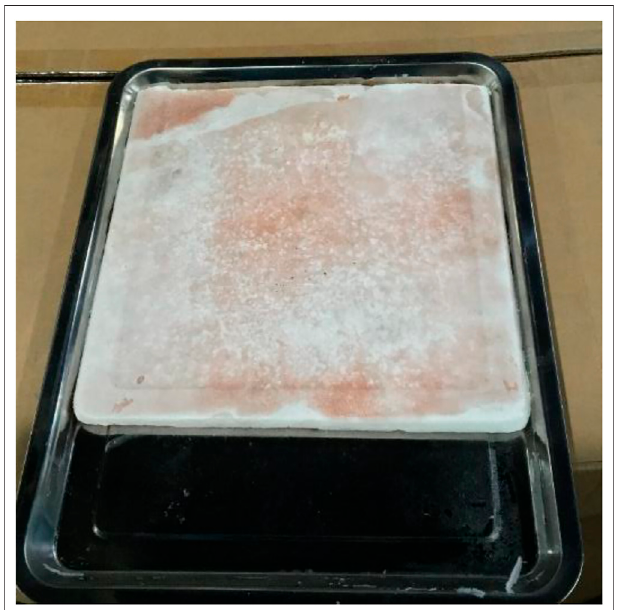
FIGURE 6 | PCM composite board made of copper foam/paraf fi n with pore densities of 50 ppi and 300 × 300 × 5 mm.